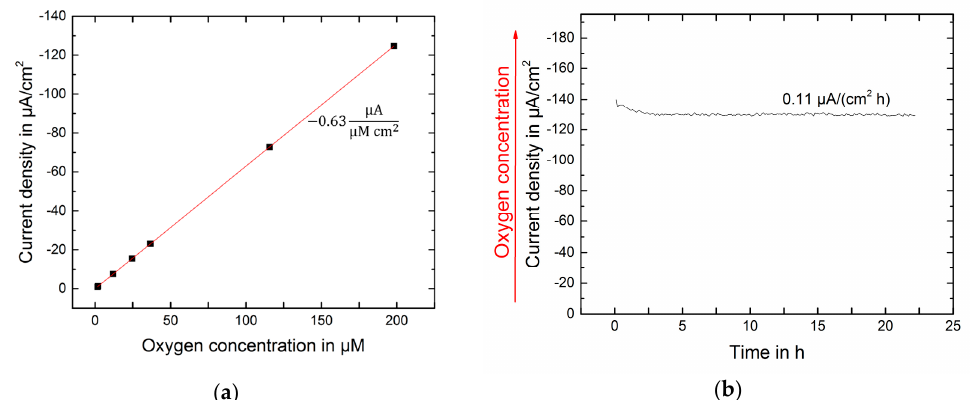
Figure 2. ( a ) Calibration of the oxygen sensors in cell culture medium at 37 °C; ( b ) Oxygen measured in cell culture medium in the incubator at 37